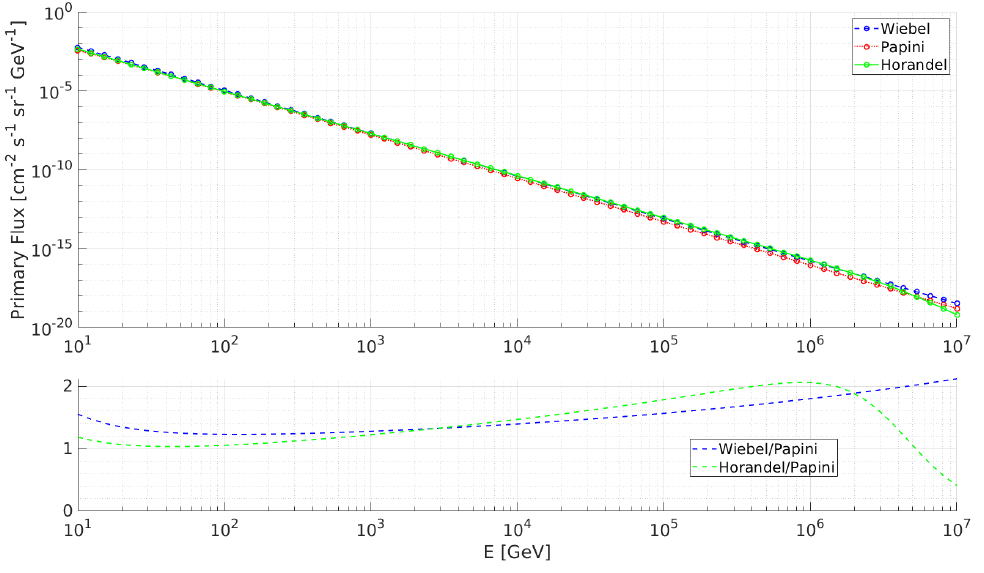
Figure 1. ( Top ) Primary cosmic ray fluxes (Hörandel [45], Papini [34] and Wiebel-Sooth [46]) for all components as a function of the energy of the primary particle. ( Bottom ) Ratio of these fluxes as a function of the energy of the primary